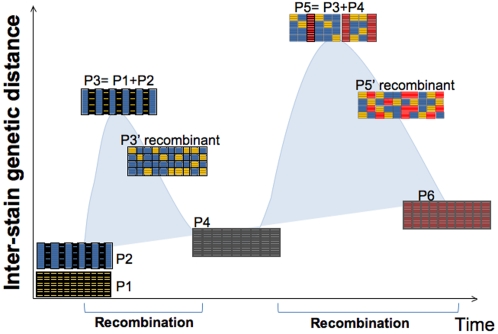
Development of inter-strain genetic diversity over time as two populations recombine.In the context of our hypothesis, a low diversity H. pylori population (P1) arose from co-evolution with the isolated Amerindian host population. With the introduction of new H. pylori strains (P2) the new population formed (P3) is more diverse than any of the source populations alone. Selection acts and strains recombine with the consequent homogenization of the population (P3′). The cycle is repeated when new populations (P4) arrive. Given time and isolation (no gene flow), population diversity will be reduced (P6). Based on their mosaic structure and high genetic distances, it seems that current H. pylori from Amerindians and Mestizos are in one of the intermediate states (P3′ or P5′). Arrows indicate introduction of new populations.